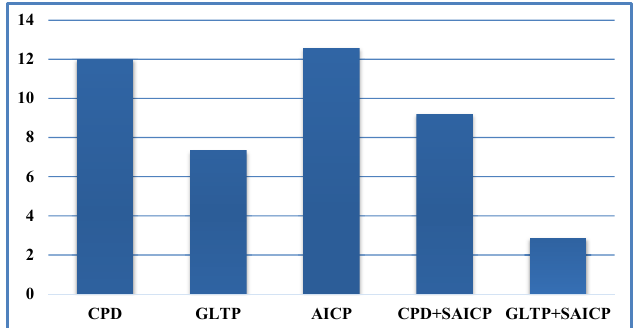
Figure 14. Result comparison on SCAPE data with average joint position errors